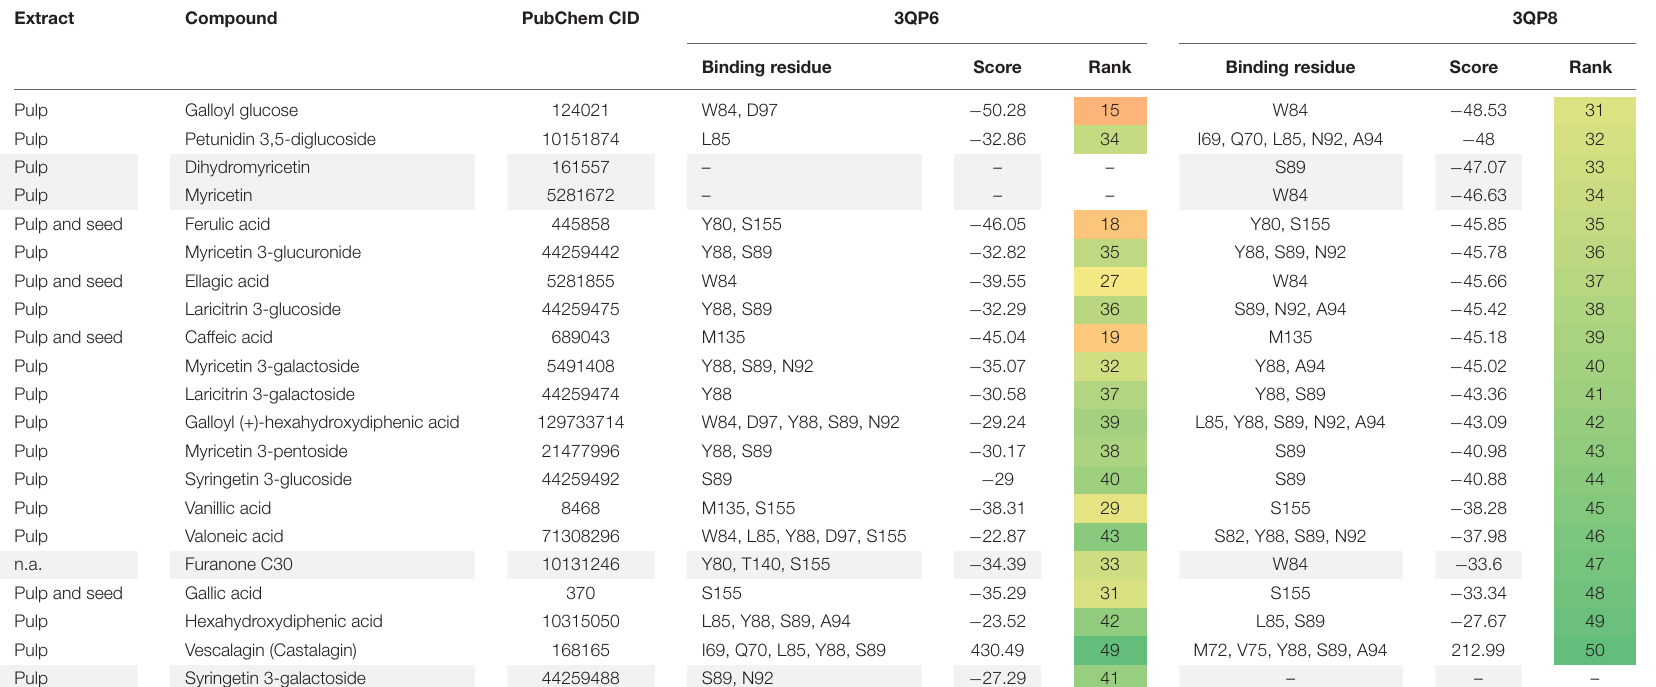
Pulp n.a., not applicable; –, the compound did not bind to the CviR protein; Rank, binding affinity scale between CviR protein with 3-OH-C10-HSL, C10-HSL, C6-HSL, furanone C30, and 47 compounds found in pulp and seed extracts of S. cumini (L.) Skeels based on score value. The color of this scale is a color ramp ranging from dark pink (higher affinity) to dark green (lower affinity) and hyphen for no binding. The main results discussed in the text are shown with gray